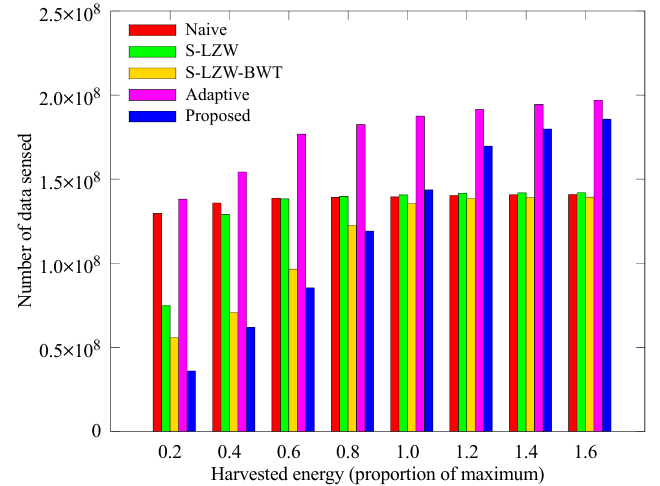
Figure 15. Comparison of the number of data sensed according to the solar